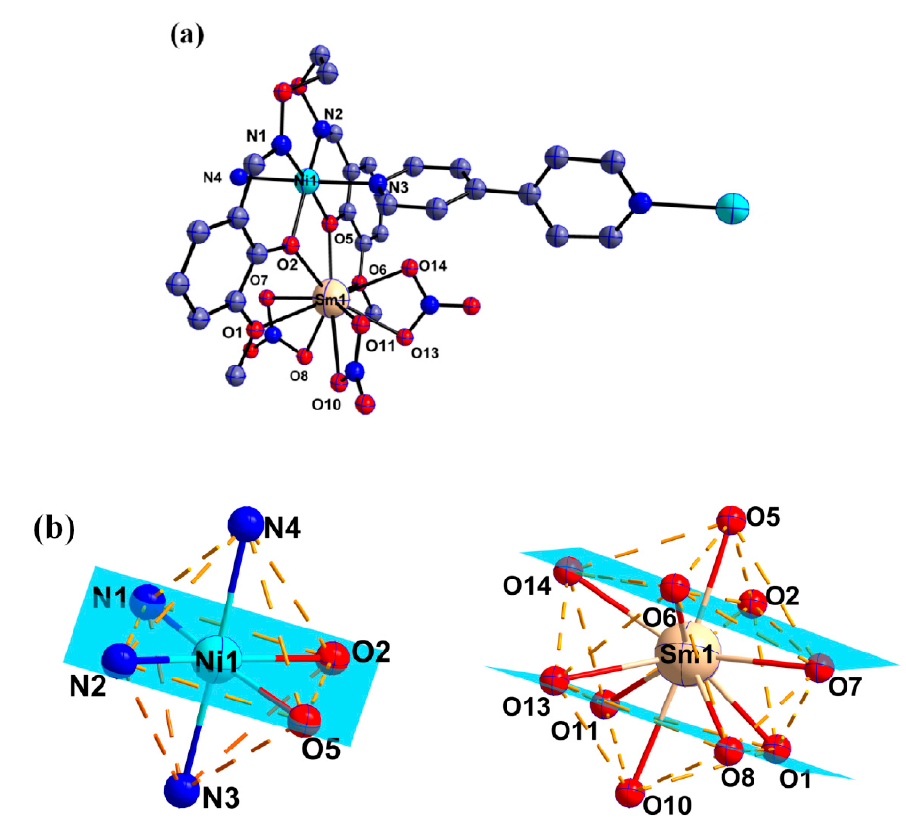
Figure 3. ( a ) Molecular structure and atom numberings of the title polymer. ( b ) Coordination polyhedra for Sm(III) and Ni(II) atoms in the title polymer. Table 2. Selected bond lengths (Å) and angles (deg) for the title polymer.